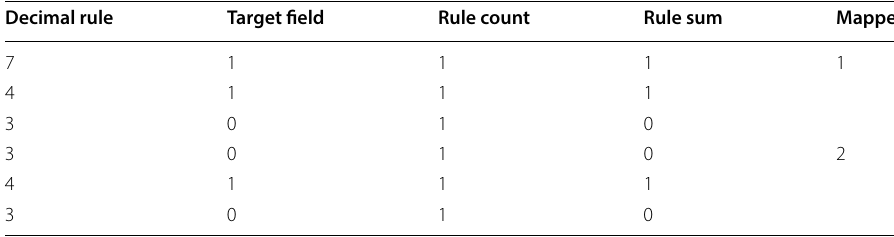
Table 4 Mapper results